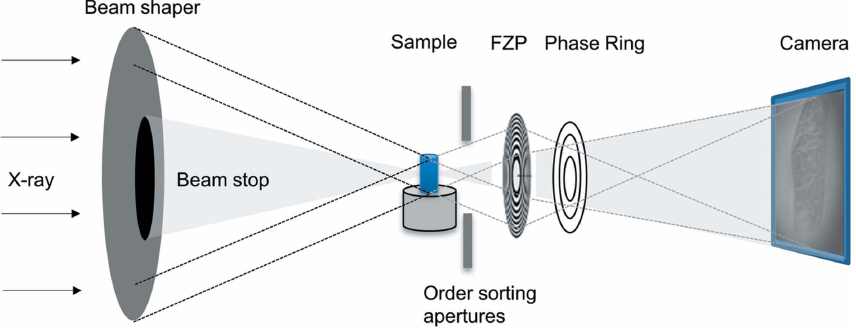
Figure 1 Schematic of a typical transmission X-ray microscopy setup used at P05, PETRA III (DESY, Germany) (adapted from Flenner et al. ,